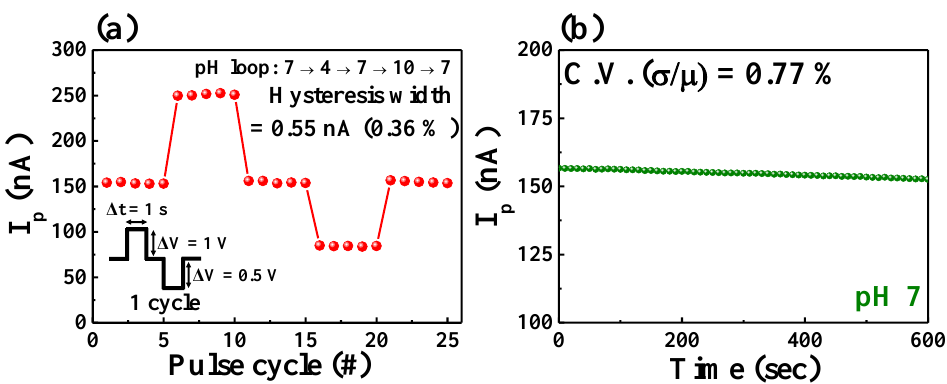
Figure 7. ( a ) Hysteretic and ( b ) drift responses of a time-dependent pH sensor by using a chitosan/Ta 2 O 5 hybrid dielectric EDLT.